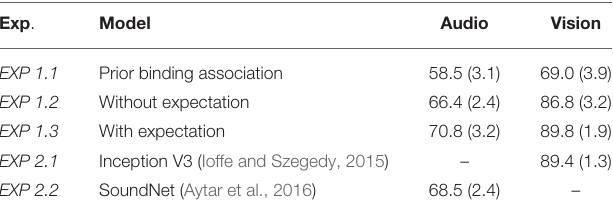
TABLE 4 | Mean accuracy, in percentage, and standard deviation of our